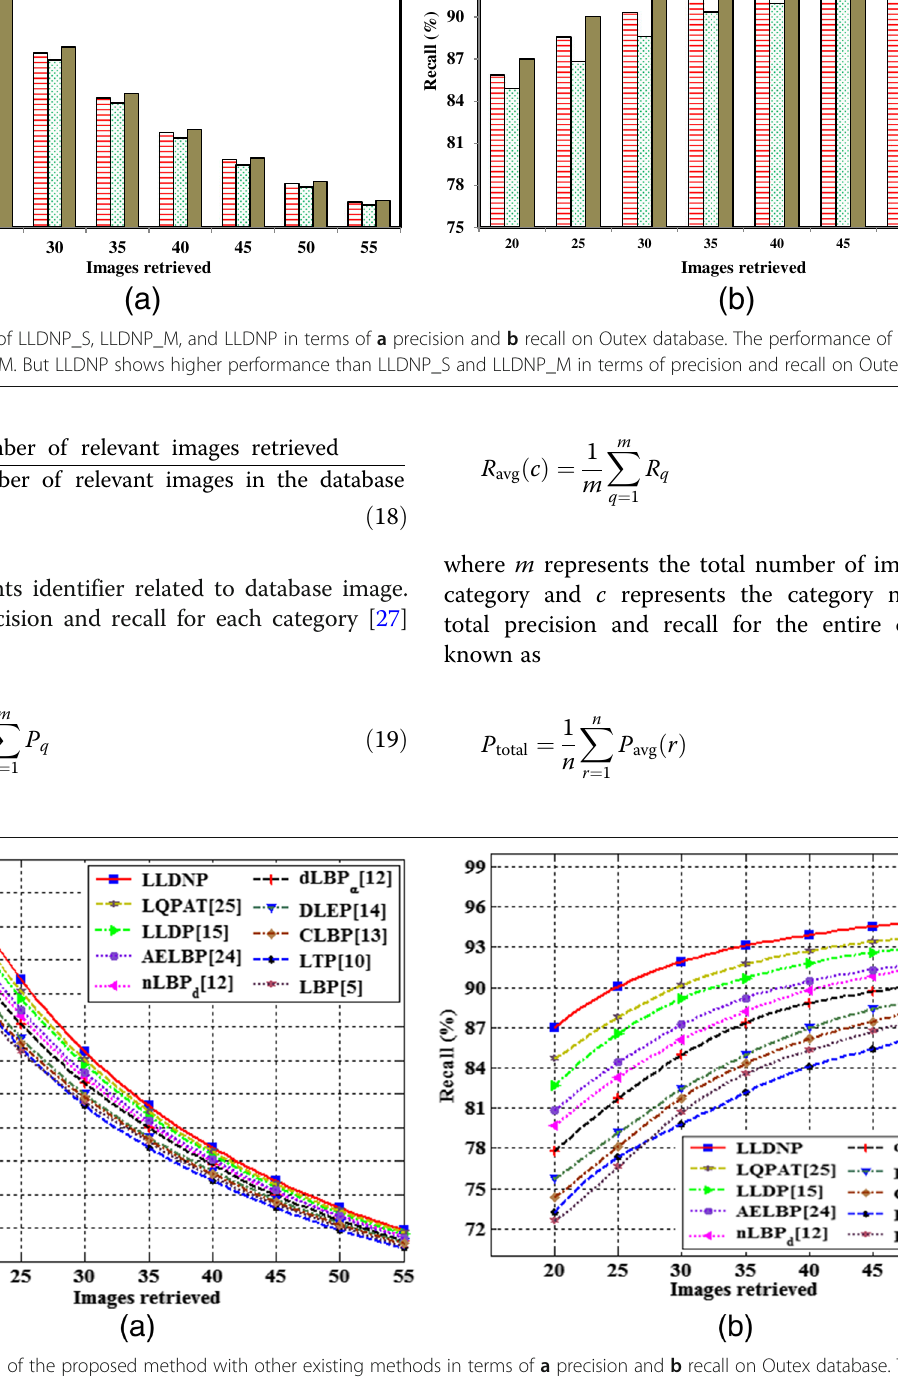
Fig. 10 Comparison of the proposed method with other existing methods in terms of a precision and b recall on Outex database. The performance of existing methods and proposed LLDNP in terms of precision and recall is analyzed. Initially, 20 images are extracted from the database and thereafter the retrieval of images goes up to 55 through a gradual increase at 5 per query. The proposed LLDNP shows improved performance than the other existing methods on Outex database